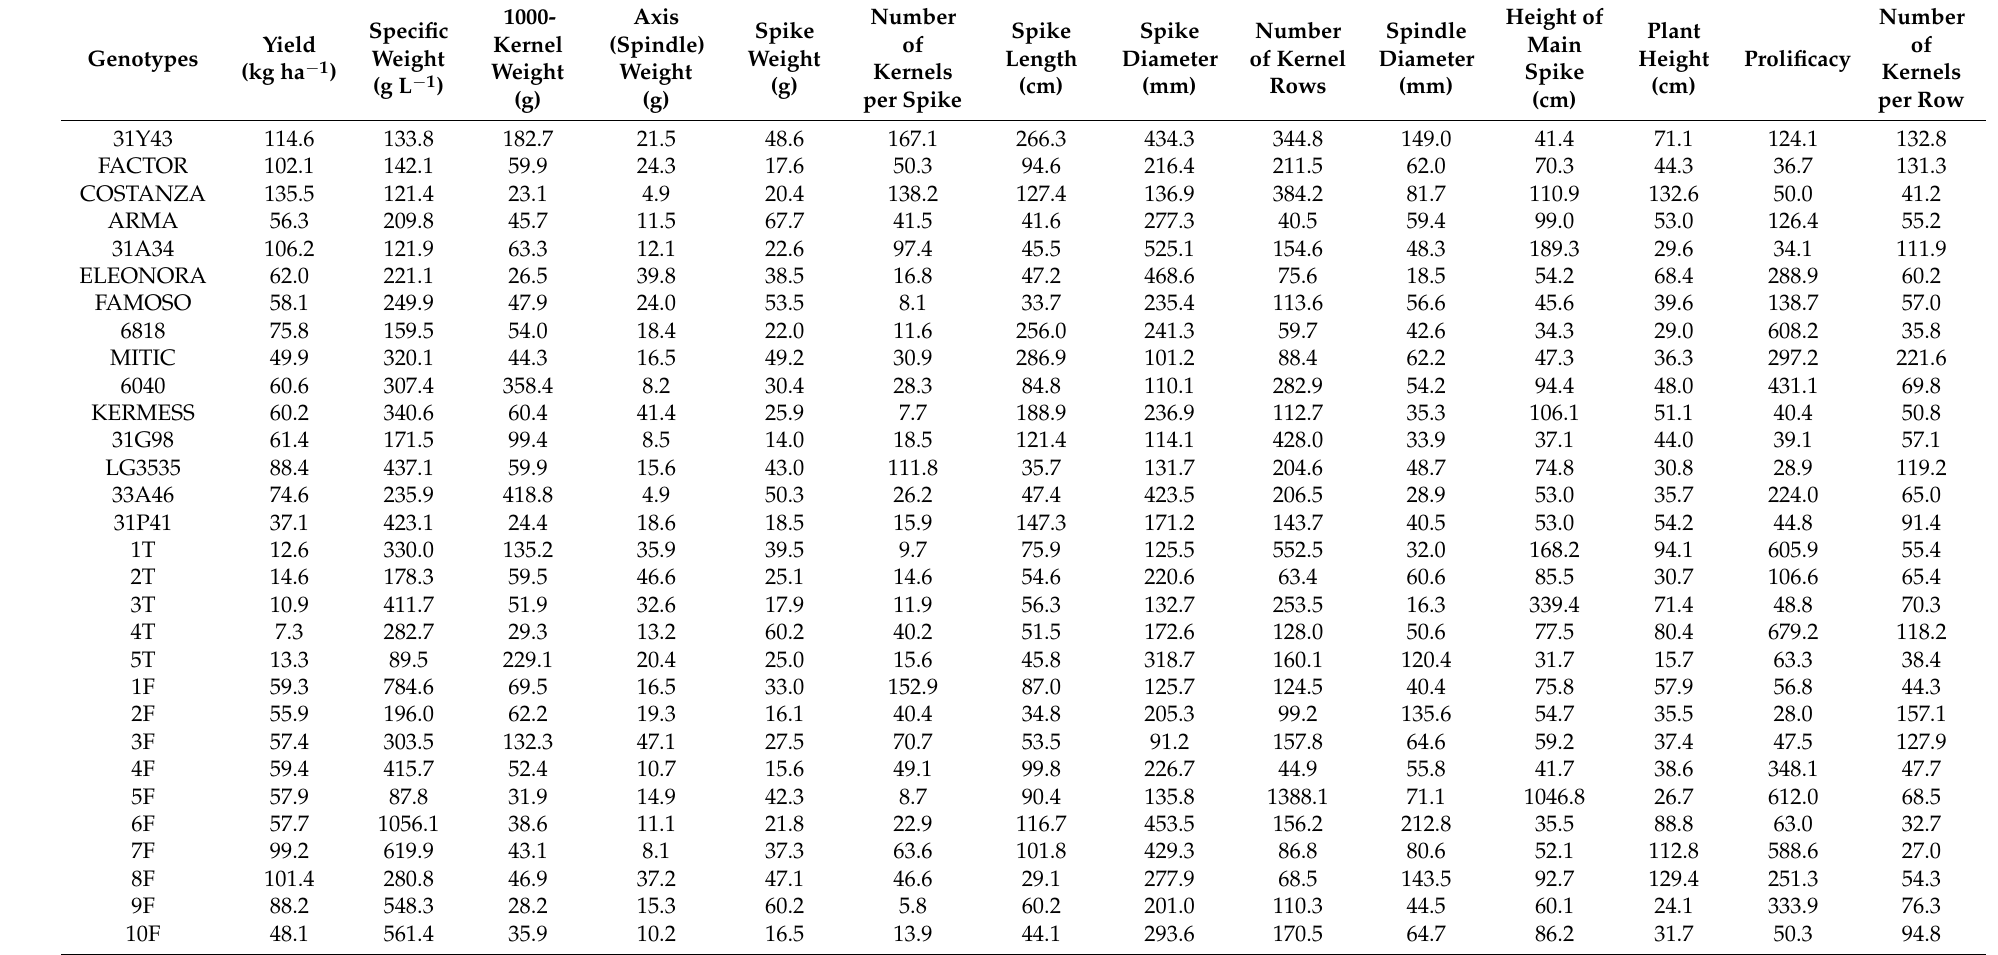
Table 4. Trait stability index ( x / s ) 2 across genotypes and environments for tested traits: yield (kg ha − 1 ), specific weight (g L − 1 ), 1000-kernel weight (g), axis (spindle) weight (g), spike weight (g), number of kernels per spike, spike length (cm) and diameter (mm), number of kernel rows, spindle diameter (mm), main spike and plant height (cm), prolificacy, and number of kernels per row, in Florina